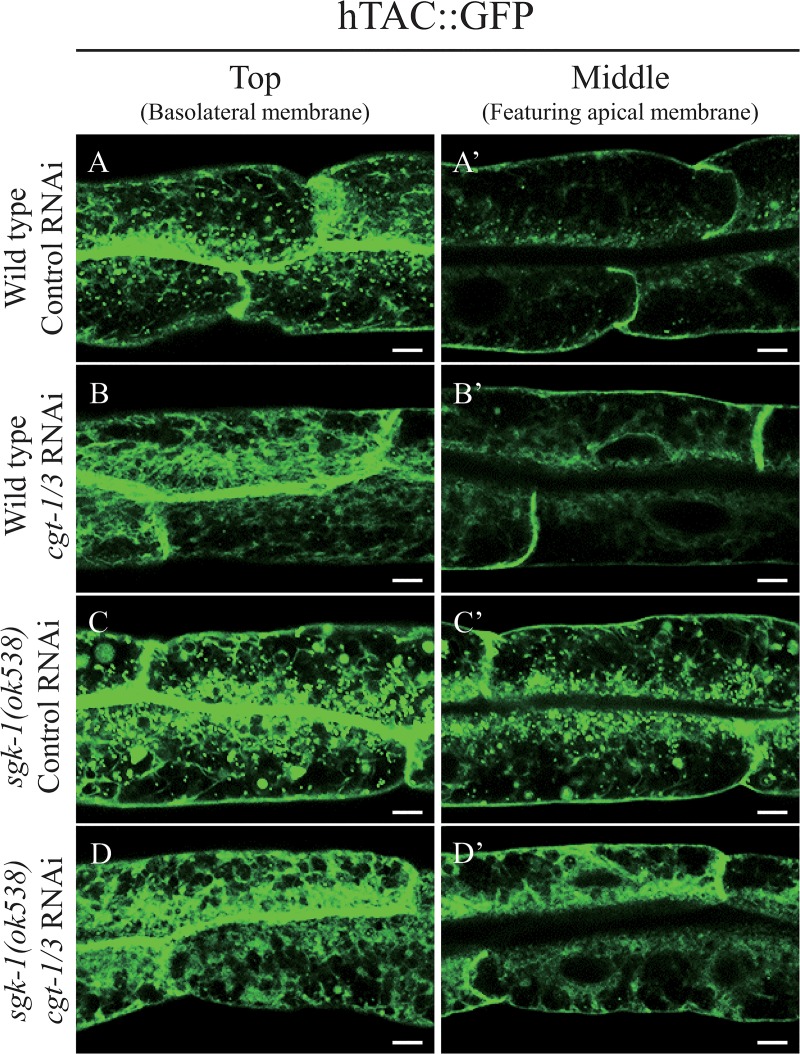
The effect of cgt-1/3 double RNAi on the localization patterns of hTAC::GFP.Confocal images of intestinal cells of wild type worms treated with control RNAi (A, A’), cgt-1/3 double RNAi (B, B’) and sgk-1(ok538) mutant animals treated with control RNAi (C, C’), cgt-1/3 double RNAi (D, D’) expressing hTAC::GFP. The basolateral membranes were indicated by arrows. Scale bars: 5 μm.